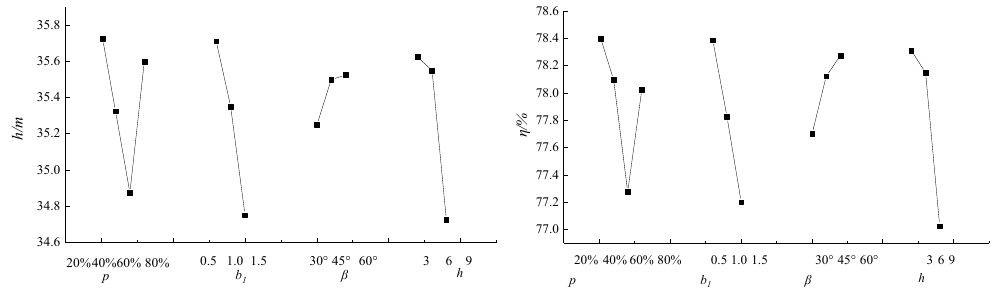
Figure 8. 1.0 Q head ( left ) and efficiency ( right )-factor relationship.